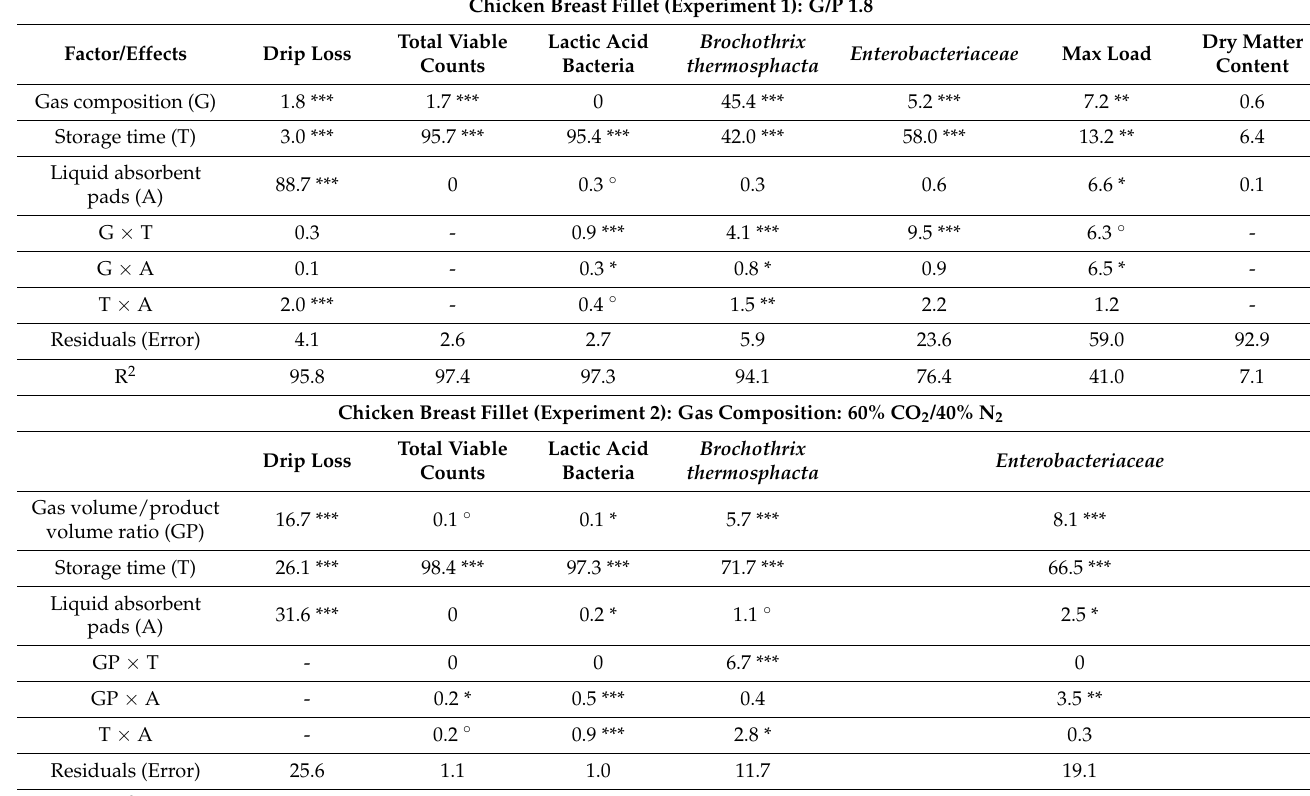
Table A1. Summaries of analyses of variance for measurements on chicken breast fillets (Experiments 1 and 2). Numbers show percentage of variation per